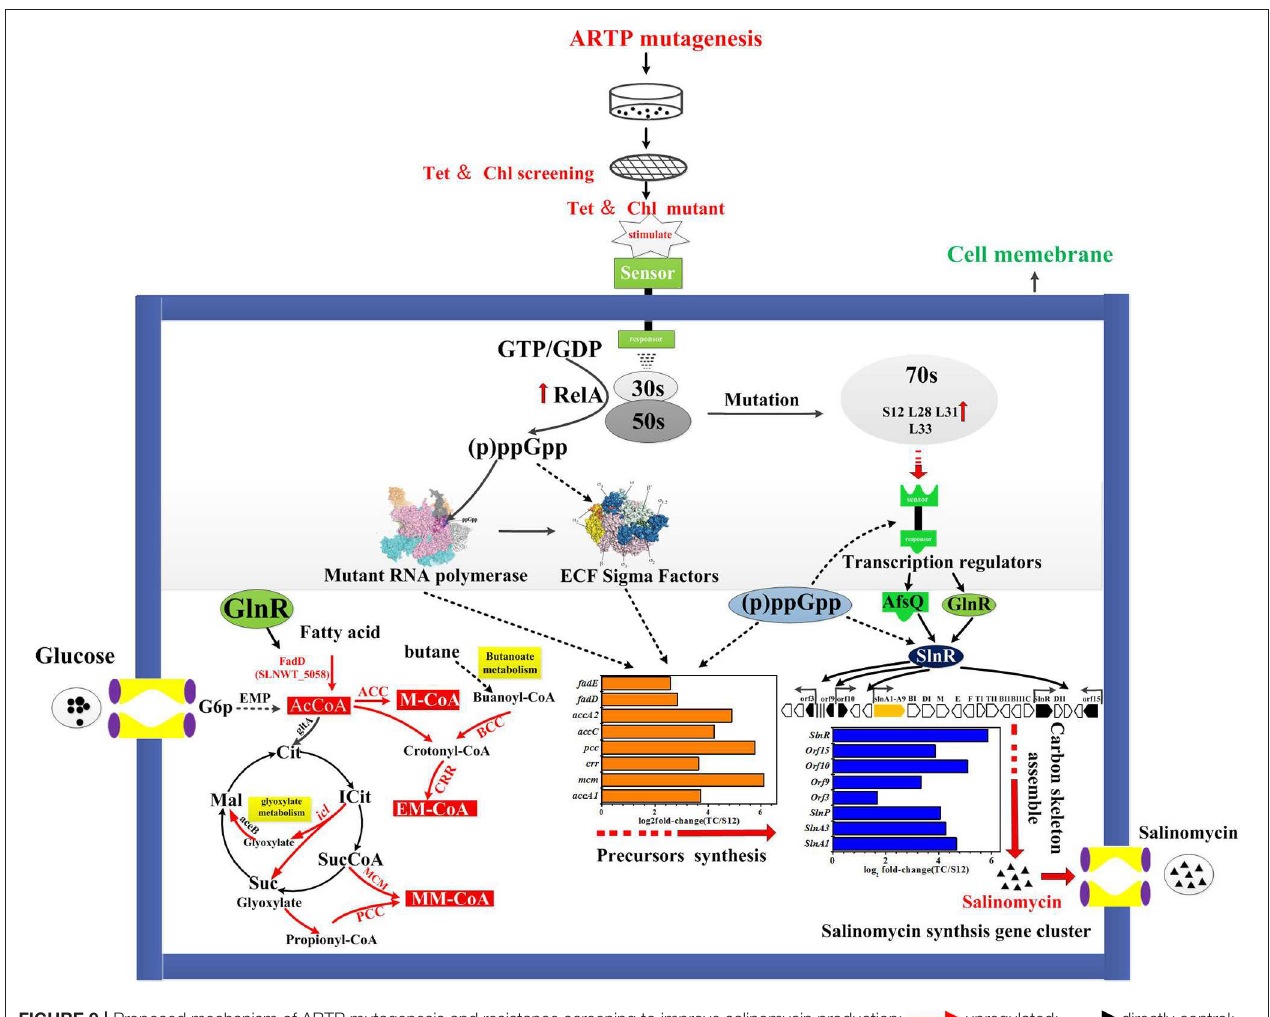
FIGURE 9 | Proposed mechanism of ARTP mutagenesis and resistance screening to improve salinomycin production: upregulated; directly control; indirectly control; or